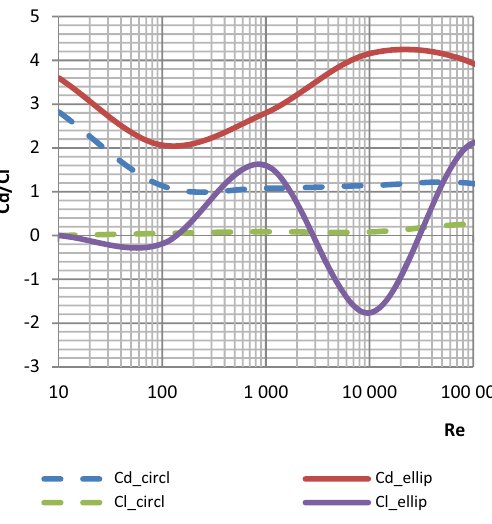
Fig.8. Drag coefficient Cd and lift coefficient Cl against Reynolds number, for ellipse and circle